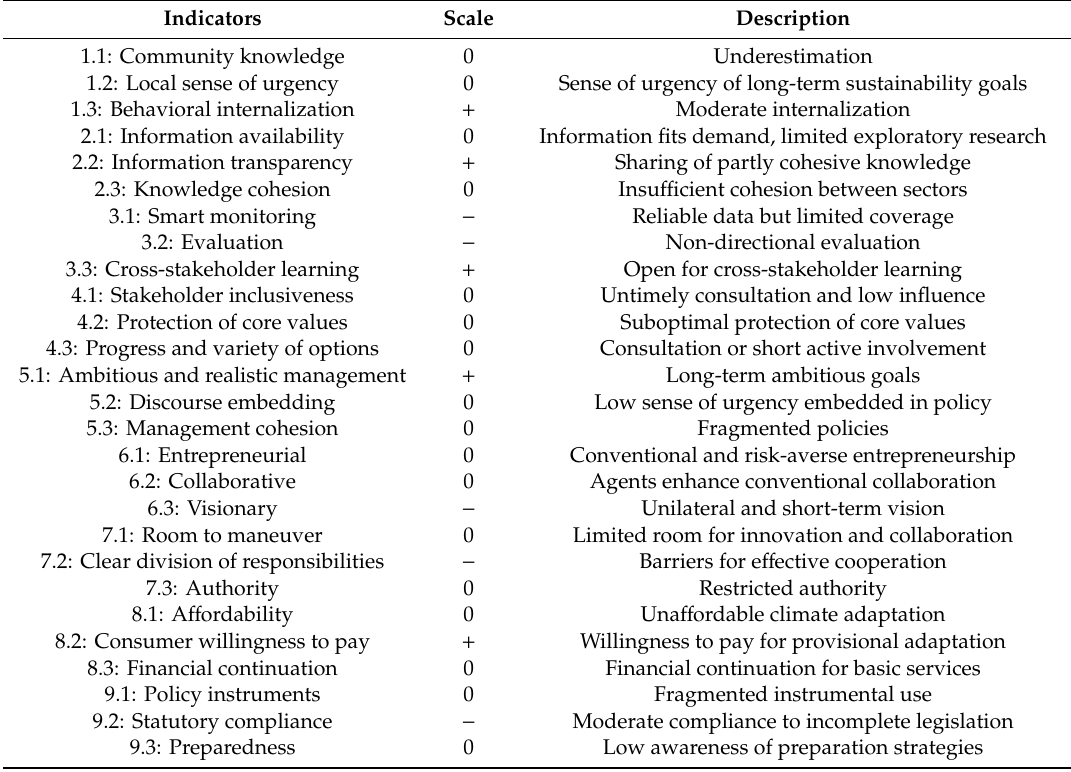
Table 5. Governance Capacity Framework results for Ulaanbaatar on